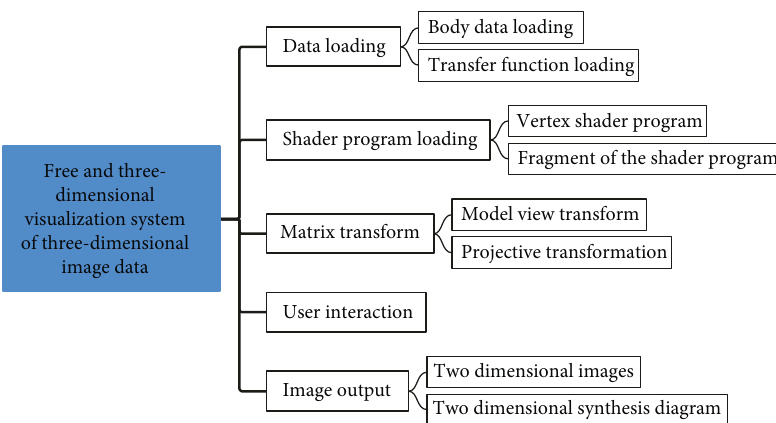
Figure 8: System function block